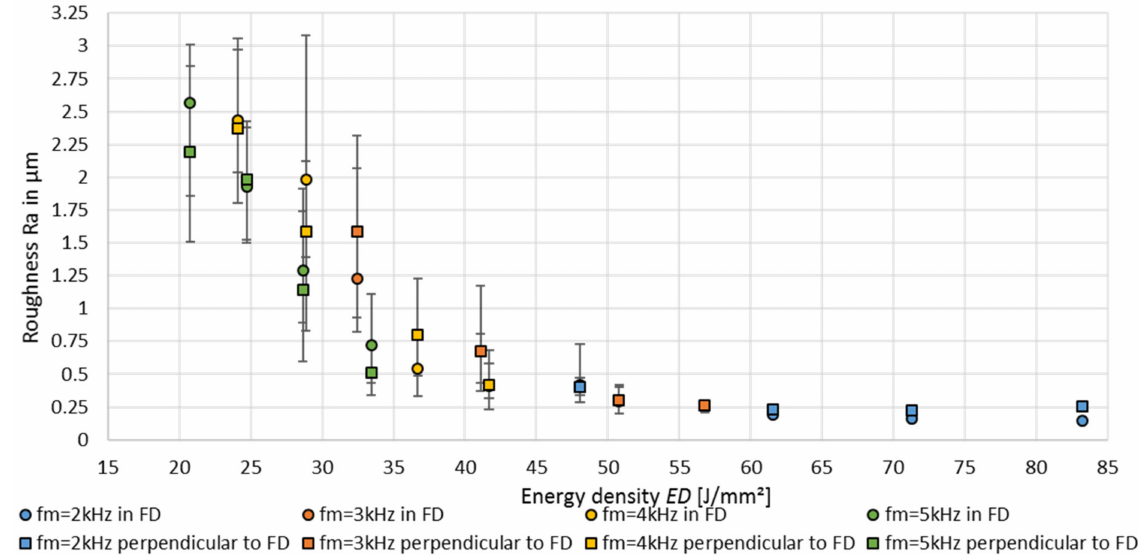
Figure 10. Achievable roughness Ra, depending on the modulation frequency, as a function of the energy density ED